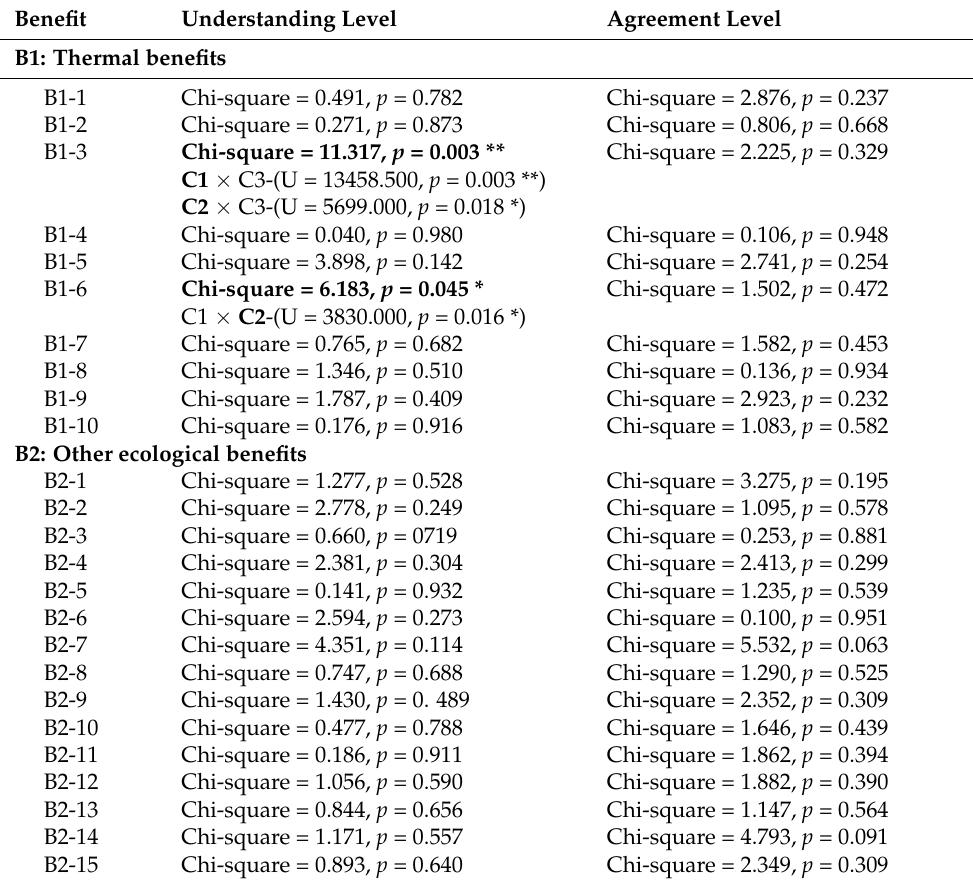
Table 5. Impacts of the childhood living environments on respondents’ perceptions of UGS ecological benefits a